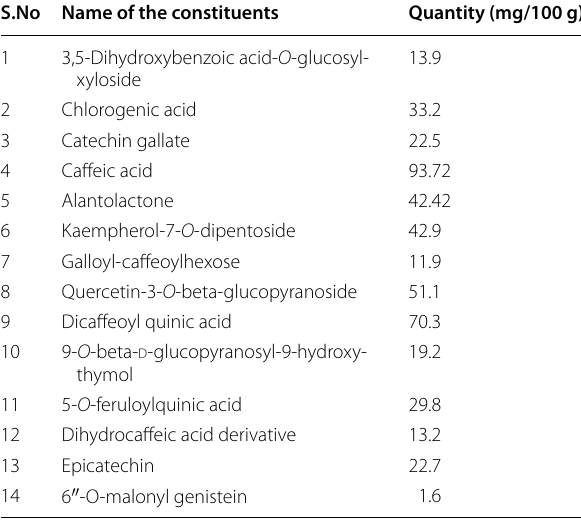
Table 2 The compounds obtained in the Ir